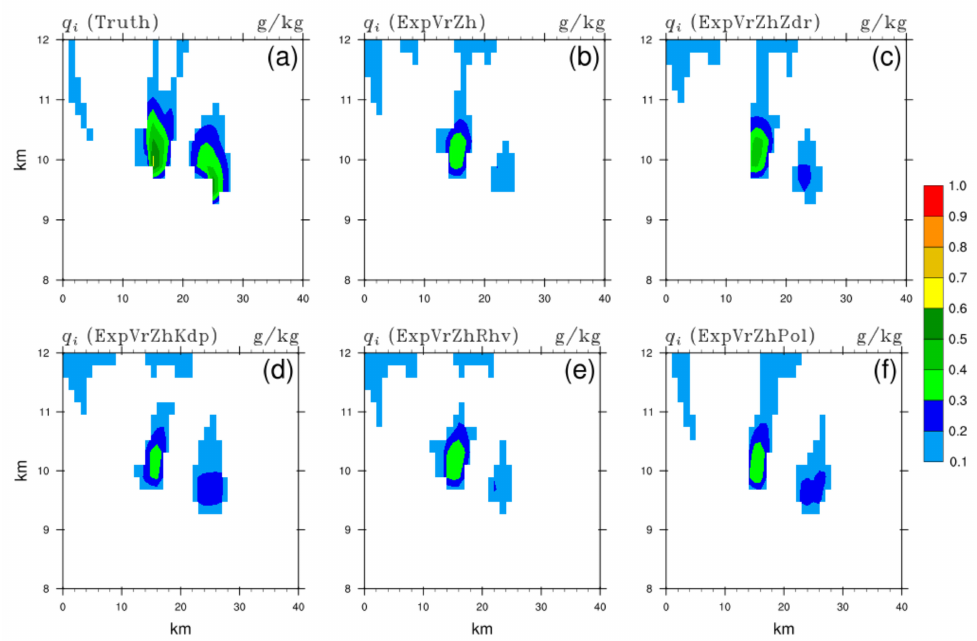
Figure 11. The same as Figure 7, but for the mixing ratio of cloud ice q i (unit: g/kg) of ( a ) truth, and analysis fields of ( b ) ExpVrZh, ( c ) ExpVrZhZdr, ( d ) ExpVrZhKdp, ( e ) ExpVrZhRhv, and ( f ) ExpVrZhPol,